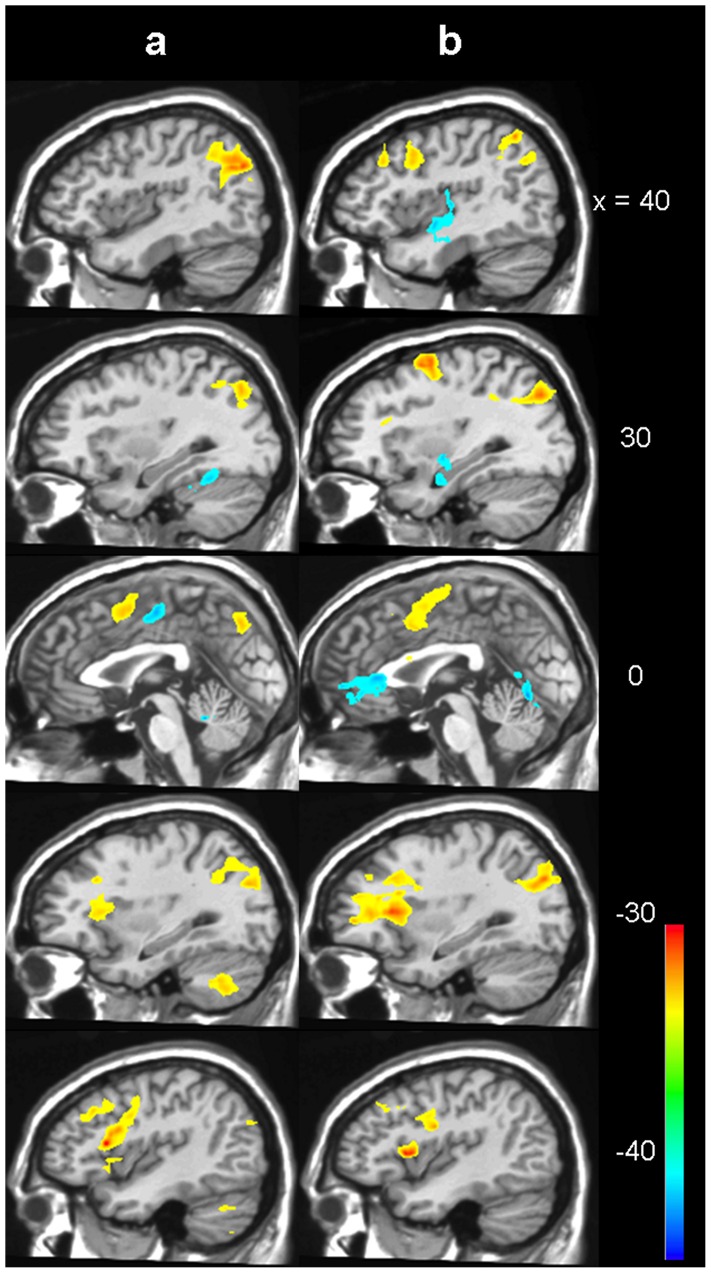
Increasing task difficulty in low lesion load.Activation change for the low lesion load group between 2-back and alertness (a) and between 2-back and 0-back (b). Blue to green means decreased activation for 2-back, yellow to red means increased activation (Z>3.3, corrected p<0.01).